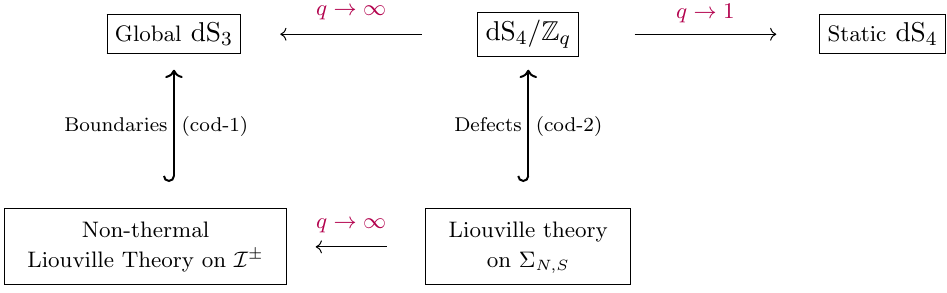
Figure 3 . Di(cid:11)erent limits of the dS 4 = Z q geometry and its defect/boundary (cid:12)eld theory description.